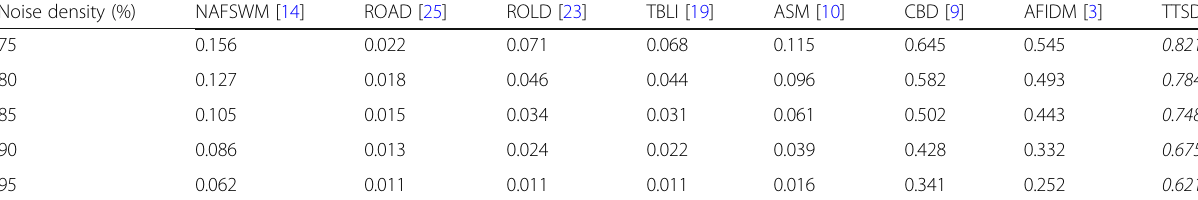
Table 5 Restoration results in average SSIM for TID2008 database corrupted by RVIN Noise density (%)